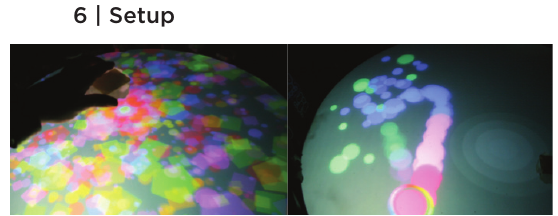
Figure 7 : Image showing the tools in